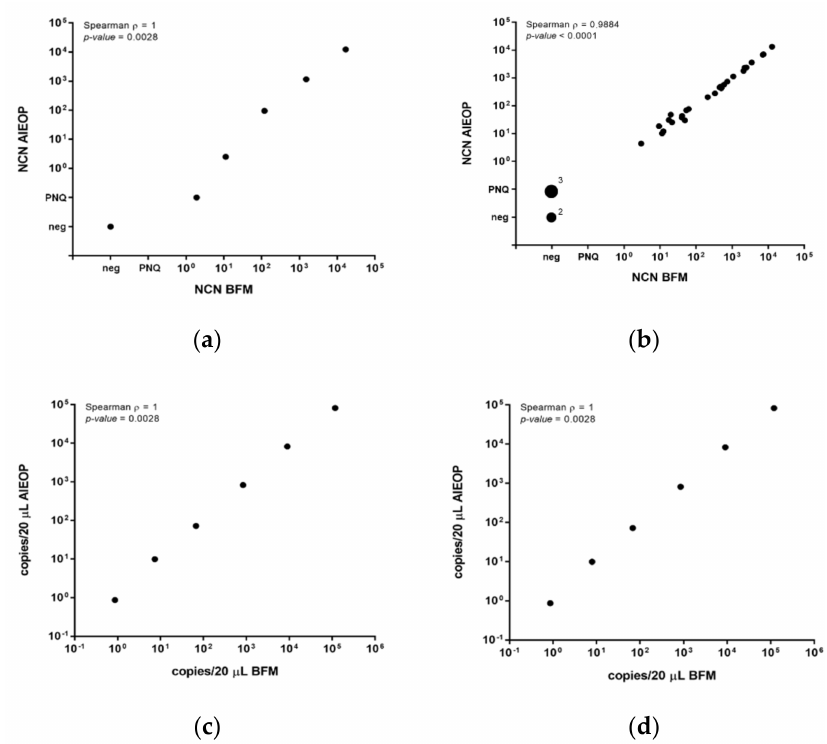
Figure 1. Quality control for MDD/MRD quantification by qPCR in an inter-laboratory setting. Comparison of normalized copy numbers (NCN) NPM-ALK (copies NPM-ALK/10 4 copies ABL1) measured by AIEOP and BFM laboratories in quality control samples represented by five serial dilutions of cDNAs from of the NPM-ALK-positive cell line SR-786 in DG-75 and a negative control ( a ) and by 33 clinical samples from NPM-ALK -positive ALCL patients ( b ). Comparison of NPM- ALK ( c ) and ABL1 ( d ) copies/20 µ L in six serial dilutions (200,000 to 2 molecules) of gBlock ® Gene Fragments with NPM-ALK and ABL1